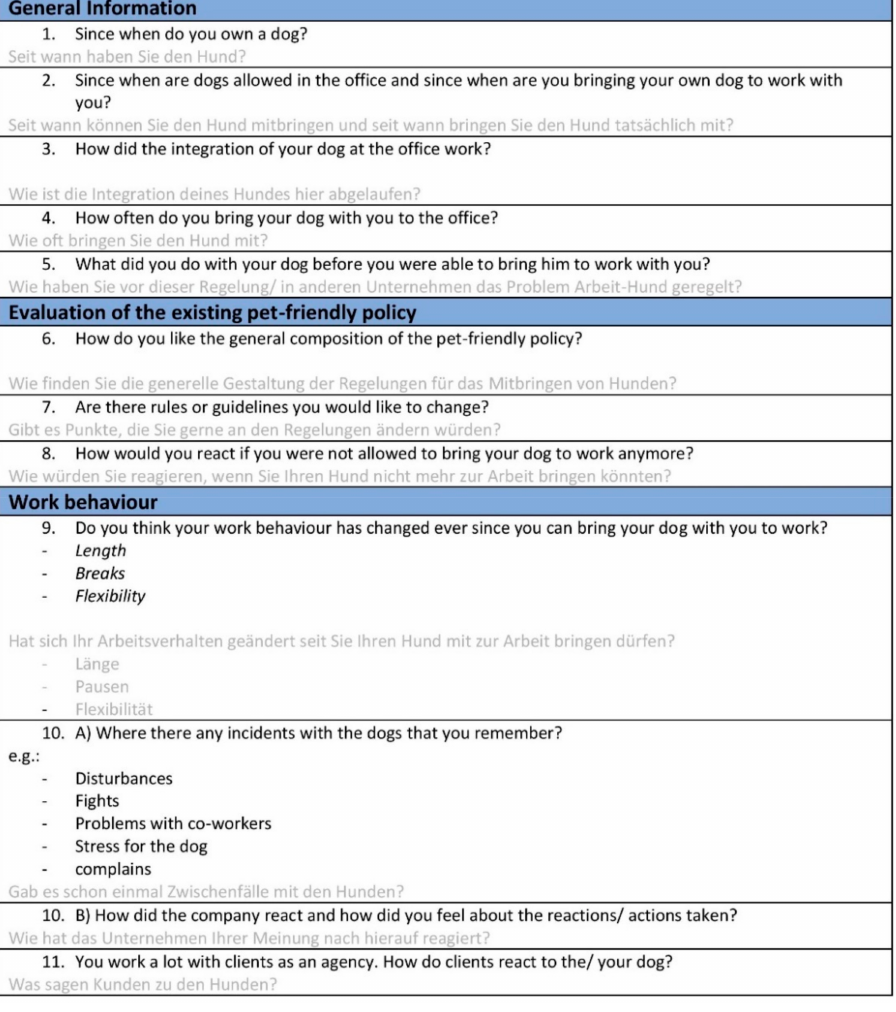
Figure 3. Interview guideline for employee who brings dog to